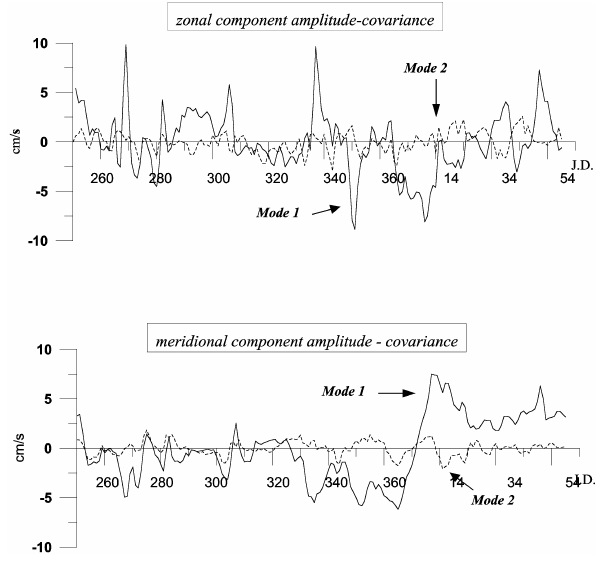
Fig. 11. Zonal and meridional component amplitude time series for the first period (04 March 2000 – 01 July 2000; J.D. 64 – J.D. 183).